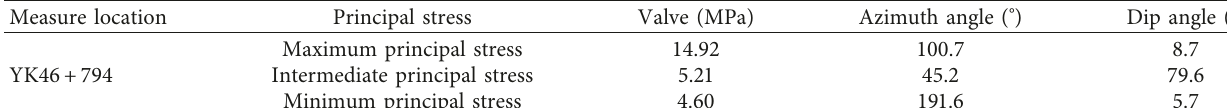
Table 1: Test results of the stress relief technique.